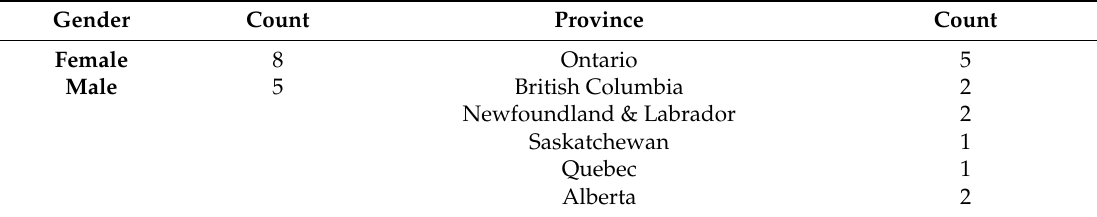
Table 2. Focus group participant